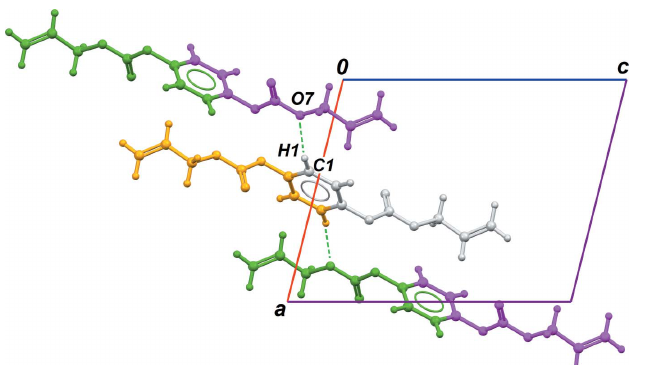
Figure 2 Part of the crystal structure based on C1—H1 (cid:2)(cid:2)(cid:2) O7 interactions (Table 1, entry 1). The asymmetric unit is coloured in grey, while orange, green and magenta moieties are generated by inversion, 2 1 axis and n glide plane, respectively.